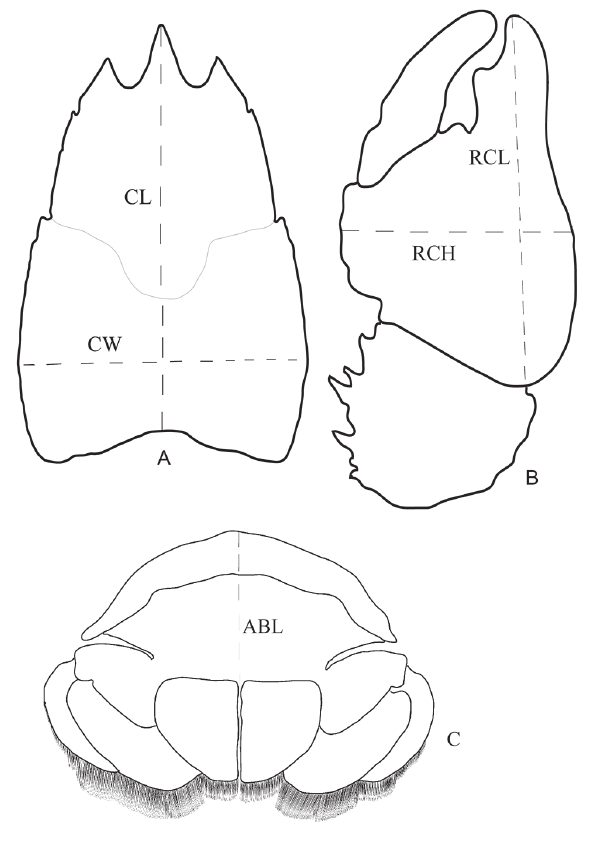
Figure 1. A: Carapace of Aegla marginata showing its measures. CL stands for Carapace Length; and CW stands for Carapace Width. B: Right cheliped of A. marginata showing the measures of chelipeds. RCL stands for Right Cheliped Length; and RCH stands for Right Cheliped Height. For the left chelae we used the same measures. C: Abdomen of A. marginata showing its measures. ABL stands for Abdomen